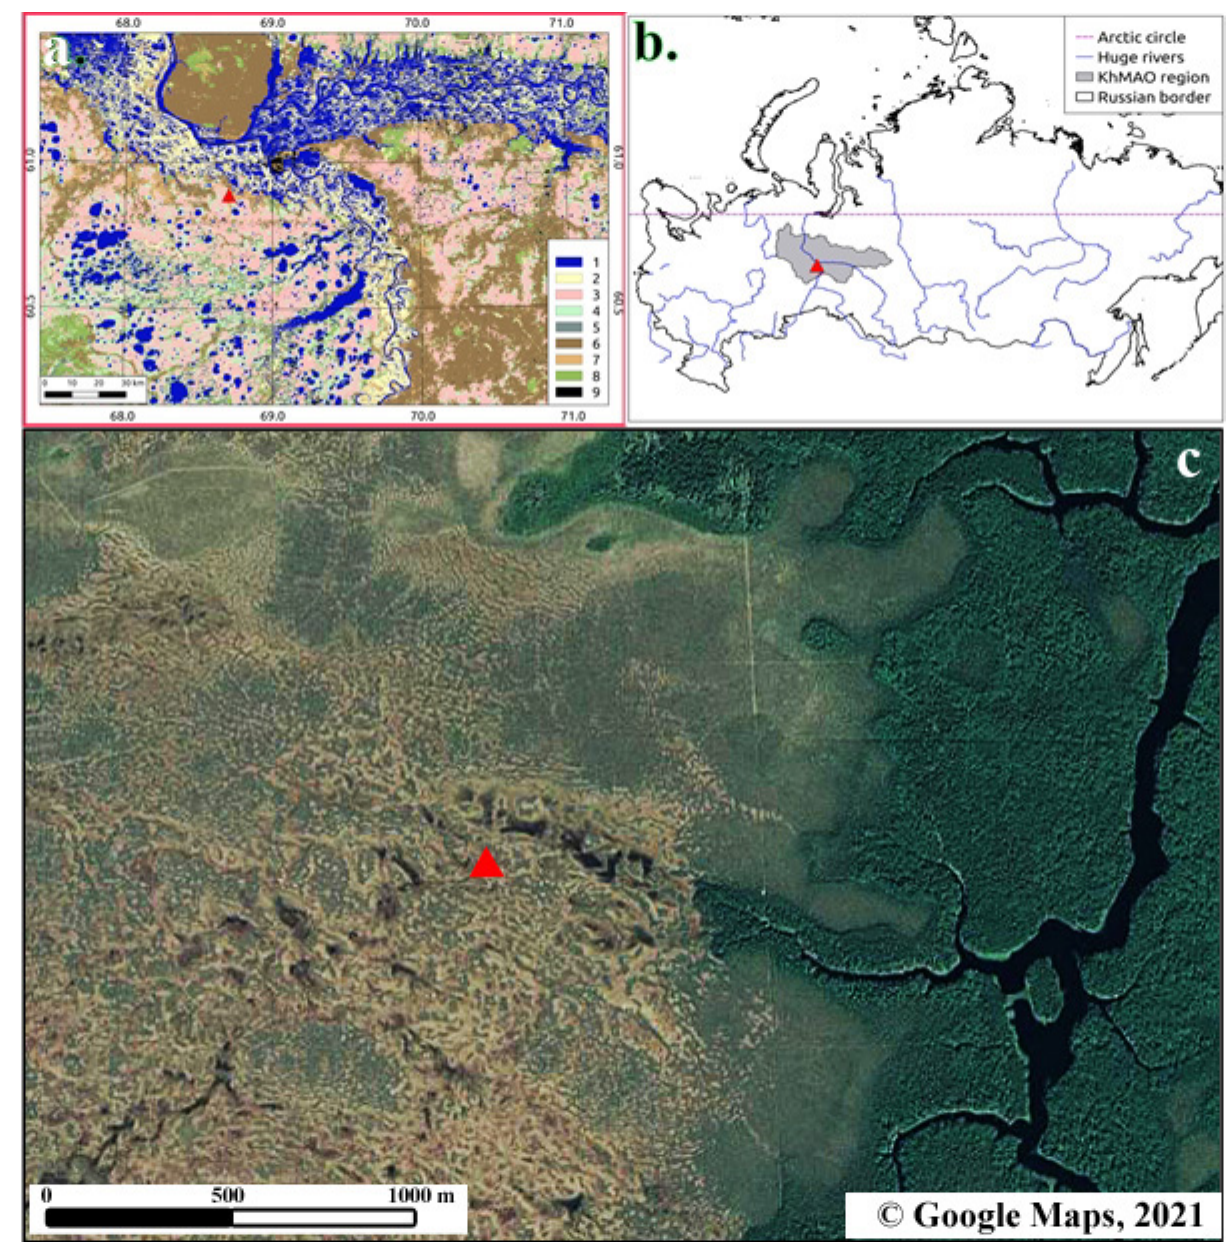
Figure 1. Position of the weather stations near Khanty-Mansiysk and among bog–forest landscapes. (a, b) 1: water; 2: floodplain; 3: ridge- hollow bog; 4: ryam bog; 5: pine forest; 6: mixed forest; 7: deciduous forest; 8: burned and disturbed forest; 9: infrastructure. (c) © QuickBird image, Google Maps,